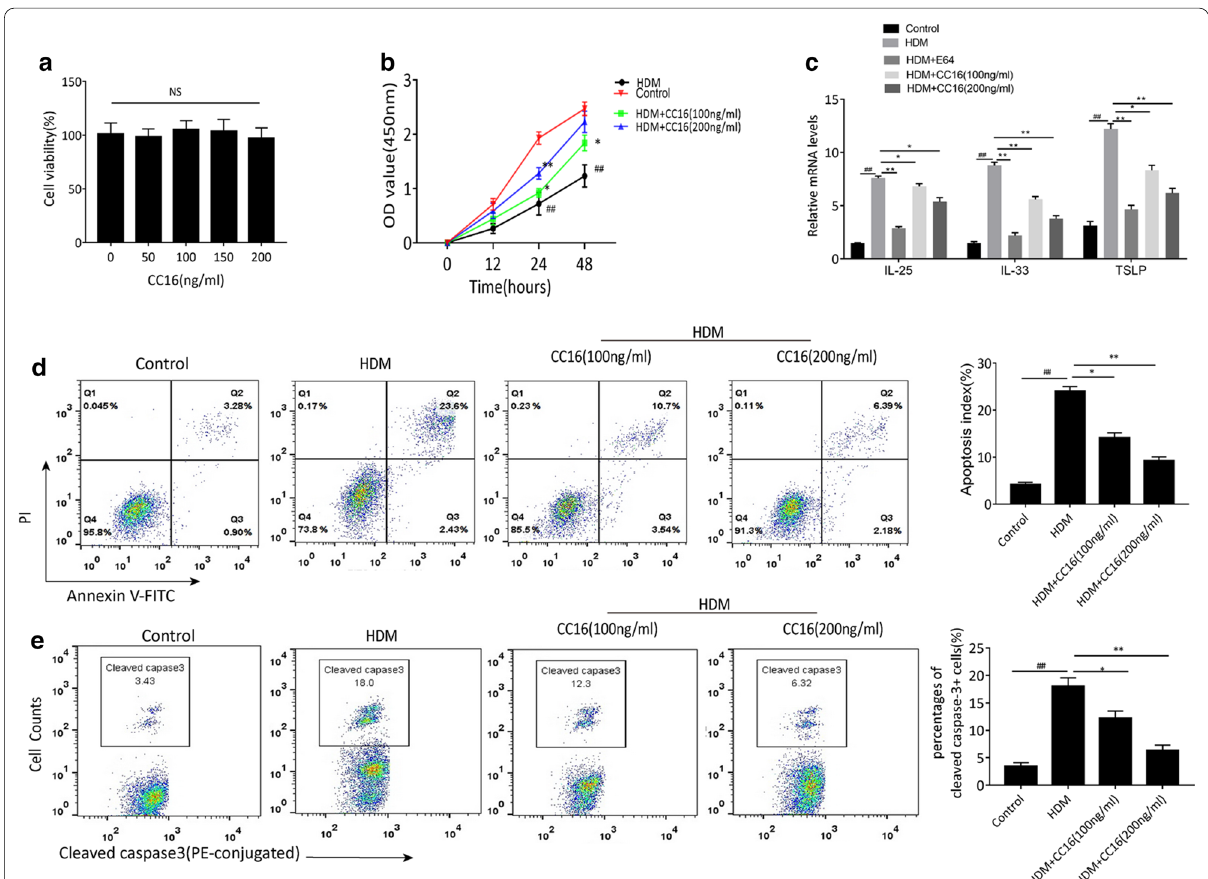
Fig. 3 CC16 improves cell viability and reduces apoptosis and inflammatory gene expression in HDM-induced BEAS-2B cells. a BEAS-2B cells were incubated in various concentrations of CC16 for 24 h. Cell viability was then analyzed by CCK-8 assay. b BEAS-2B cells were pretreated with or without different concentrations of CC16 (100 ng/ml or 200 ng/ml) for 24 h, and then stimulated with 300u/ml HDM. CCK-8 assay was performed to analyze cell viability after HDM stimulation for 12, 24, 48 h (hr). c The mRNA expression of IL-25, IL23 and TSLP were detected by RT-qPCR. d Flow analysis of apoptotic cells in the control, HDM, HDM CC16(100 ng/ml), and HDM CC16(200 ng/ml) groups. e Percentages of activated caspase-3 + + positive cells by flow cytometry in different treatment groups. Data are expressed as means SEM. ## p < 0.01 vs. Control group; *p < 0.05 vs. HDM ± group; **p < 0.01 vs. HDM